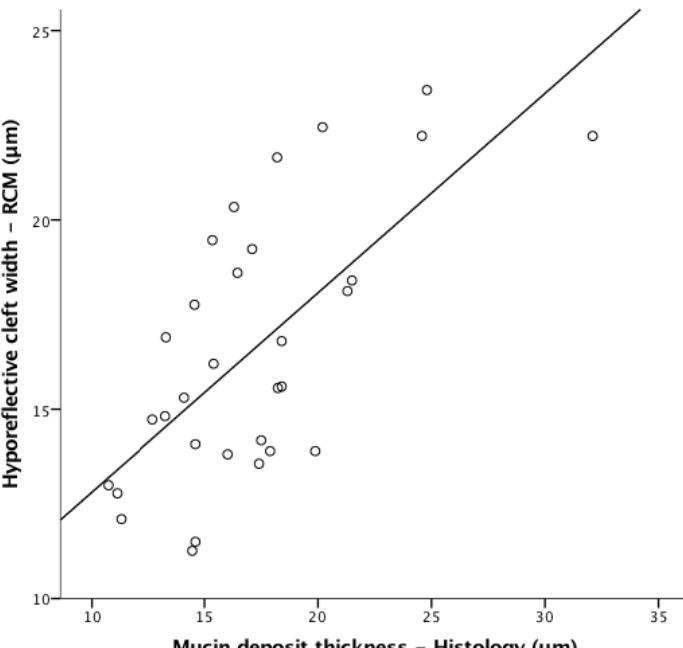
Figure 3. Scatterplot showing the correlation for mucin deposits seen on reflectance confocal microscopy (RCM) and histology. Linear correlation between cleft-like hyporeflective spaces seen on RCM examination and mucin deposits on colloidal iron-stained tissue sections. The range of measurements is fairly wide, resulting in a Pearson r = 0.675 ( p < 0.001).